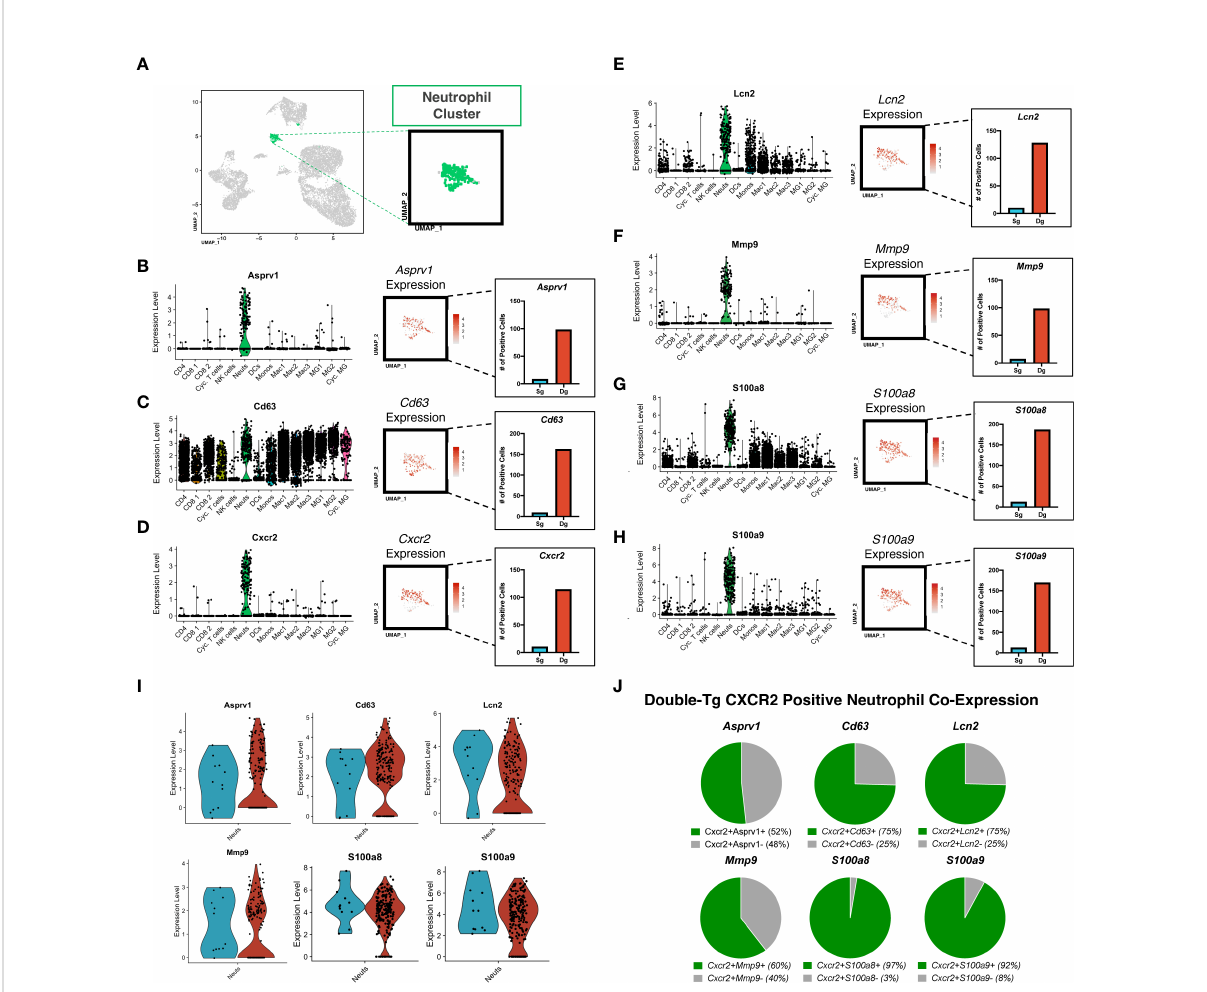
FIGURE 4 Neutrophils isolated from the spinal cord express genes associated with chemotaxis and demyelination. (A) UMAP plot showing highlighted (green) neutrophil cluster from JHMV-infected single-tg (n = 4) and double-tg (n = 4) mice. (B – H) Violin plots show expression of Asprv1 , Cd63 , Cxcr2 Lcn2 (NGAL), Mmp-9 , S100a8, S100a9 primarily within neutrophil clusters; black dots represent individual cells. Inset UMAP plots show the expression level of each gene within the neutrophil cluster. Bar graphs show the number of positive neutrophils for each respective gene for double-tg (red) and single-tg (blue) datasets. (I) Violin plots demonstrating that neutrophils from both JHMV-infected single-tg and double-tg mice express Asprv1, Cd63, Cxcr2, Lcn2 (NGAL), Mmp-9, S100a8 , and S100a9 transcripts. (J) Pie charts show the frequency of Cxcr2+ neutrophils from the double-tg mice that express Asprv1 , Cd63 , Lcn2 (NGAL), Mmp-9 , S100a8, S100a9